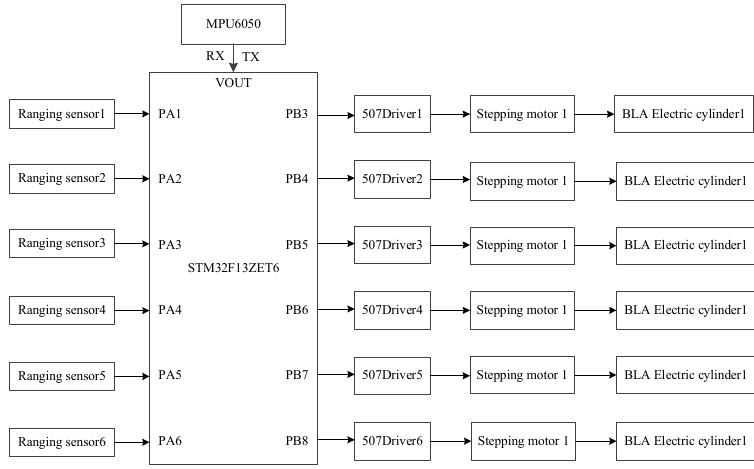
Figure 13. Schematic diagram of control circuit